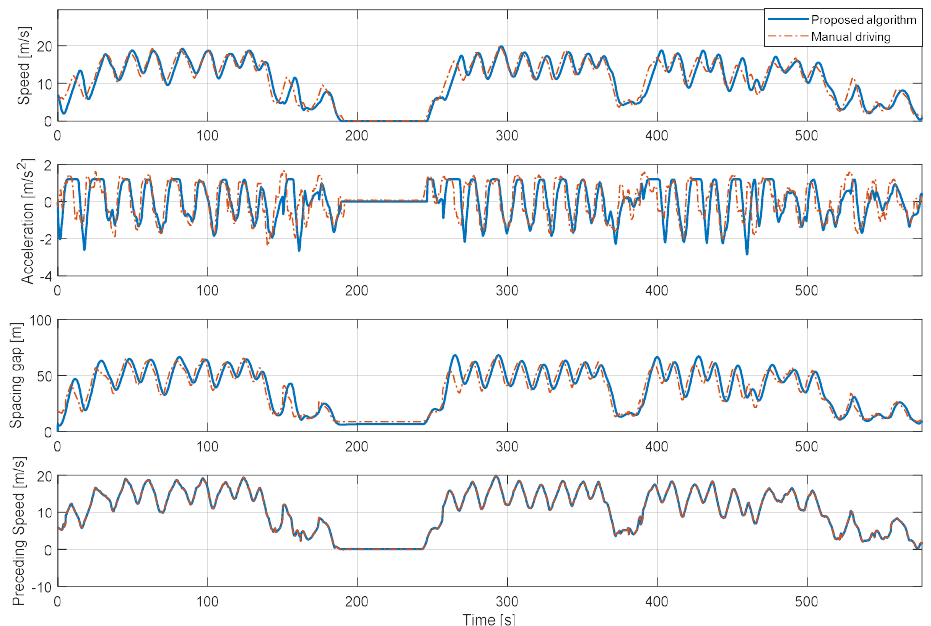
Figure 11. Driving simulation results of the proposed algorithm of 1st driver for the entire route.